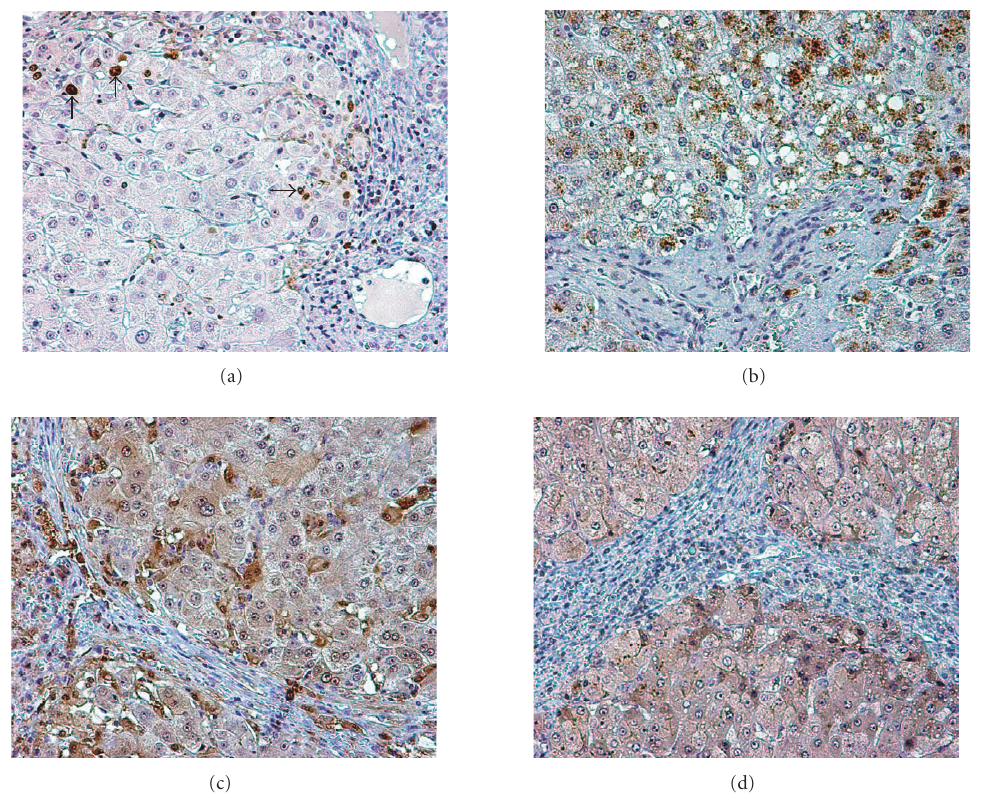
Figure 1: Immunohistchemical study of liver cirrhosis: (a) MIB1 nuclear staining in hepatocytes; (b) granular cytoplasmic expression of bFGF in hepatocytes; (c) thymidine phosphorylase expression in the cytoplasm and nuclei of hepatocytes ; (d) cytoplasmic expression of VEGF in hepatocytes. The adjacent fibrous bands do not express any of these proteins.